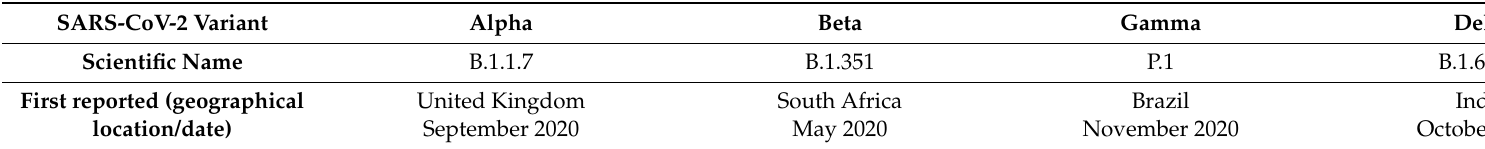
Table A1. Characteristics of SARS-CoV-2 variants of